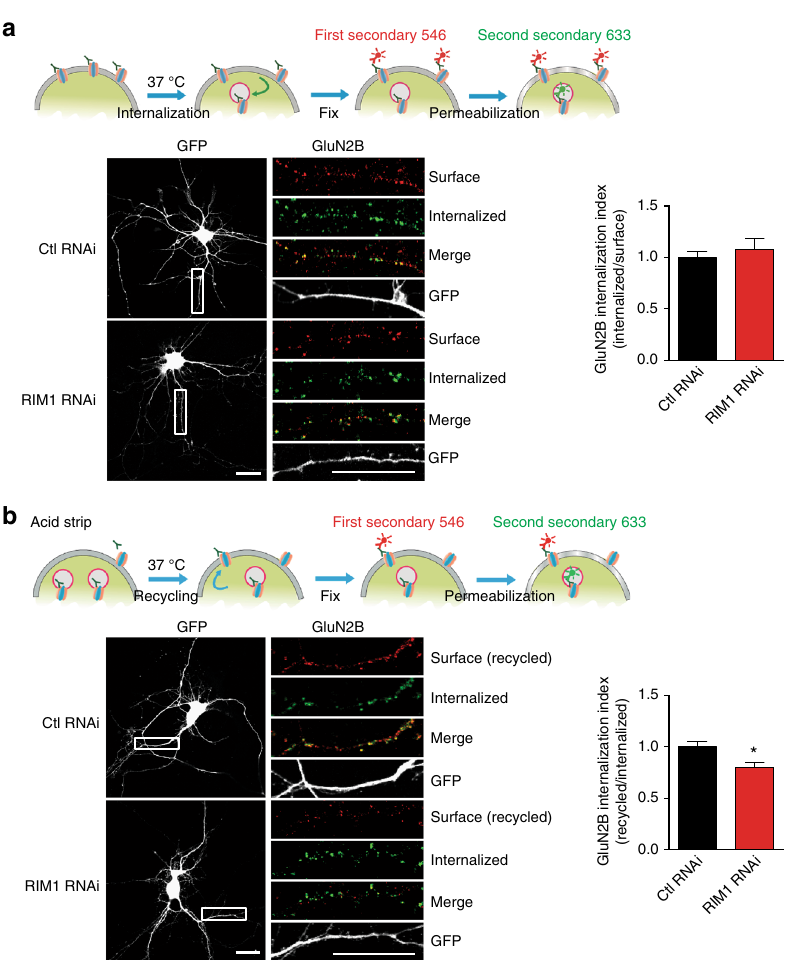
Fig. 7 RIM1 KD affects the recycling of GluN2B/NMDARs, but not their internalization. a RIM1 KD has no effect on the endocytosis of GluN2B/NMDARs. Upper panel: timeline of the endocytosis experiments. Left: internalization of GluN2B/NMDARs in hippocampal neurons transfected with RIM1 RNAi plasmids ( n = 30 neurons from three independent cultures) or control RNAi plasmids ( n = 45 neurons from three independent cultures). Red, surface GluN2B/NMDARs; green, internalized GluN2B/NMDARs. Scale bar, 20 µ m. Right: statistical analysis of internalized/surface ratio of GluN2B/NMDARs; t - test, p > 0.05. b RIM1 KD signi fi cantly decreases the recycling of GluN2B/NMDARs. Upper: timeline of the recycling experiments. Left: recycling of GluN2B/NMDARs in hippocampal neurons transfected with RIM1 RNAi plasmids ( n = 24 neurons from three independent cultures) or control RNAi plasmids ( n = 51 neurons from three independent cultures). Red, recycling GluN2B/NMDARs; green, internalized GluN2B/NMDARs. Scale bar, 20 µ m. Right: statistical analysis of recycled/internalized ratio of GluN2B/NMDARs; t -test, * p <